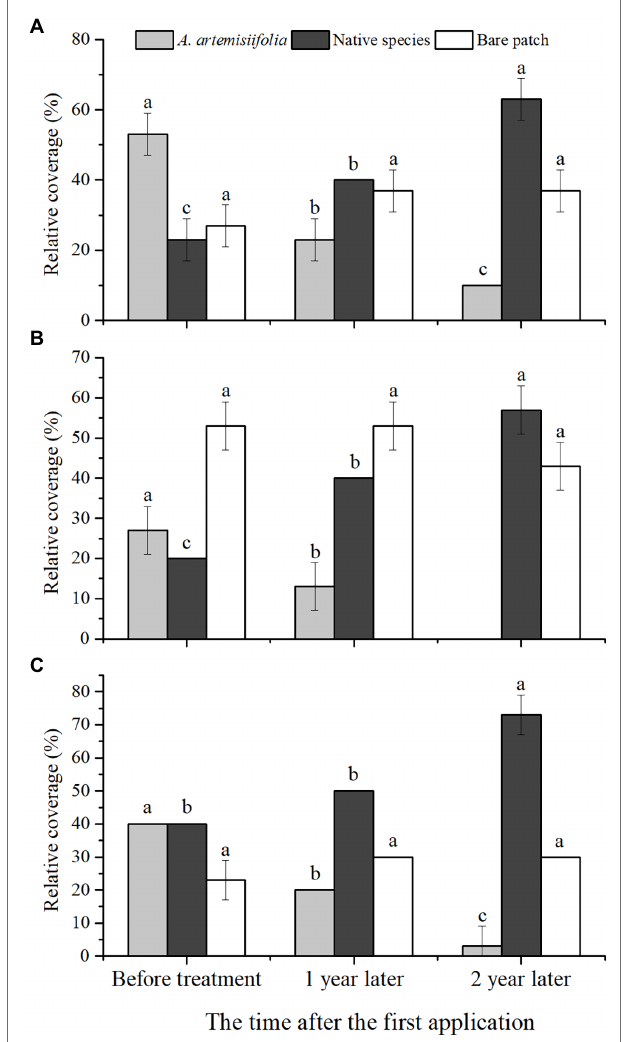
FIGURE 6 | Variation of relative coverage of each component over time in each habitat: woodland (A) , roadside (B), and farmland (C) . Different letters indicate significant differences ( p < 0.05). Values are means ±